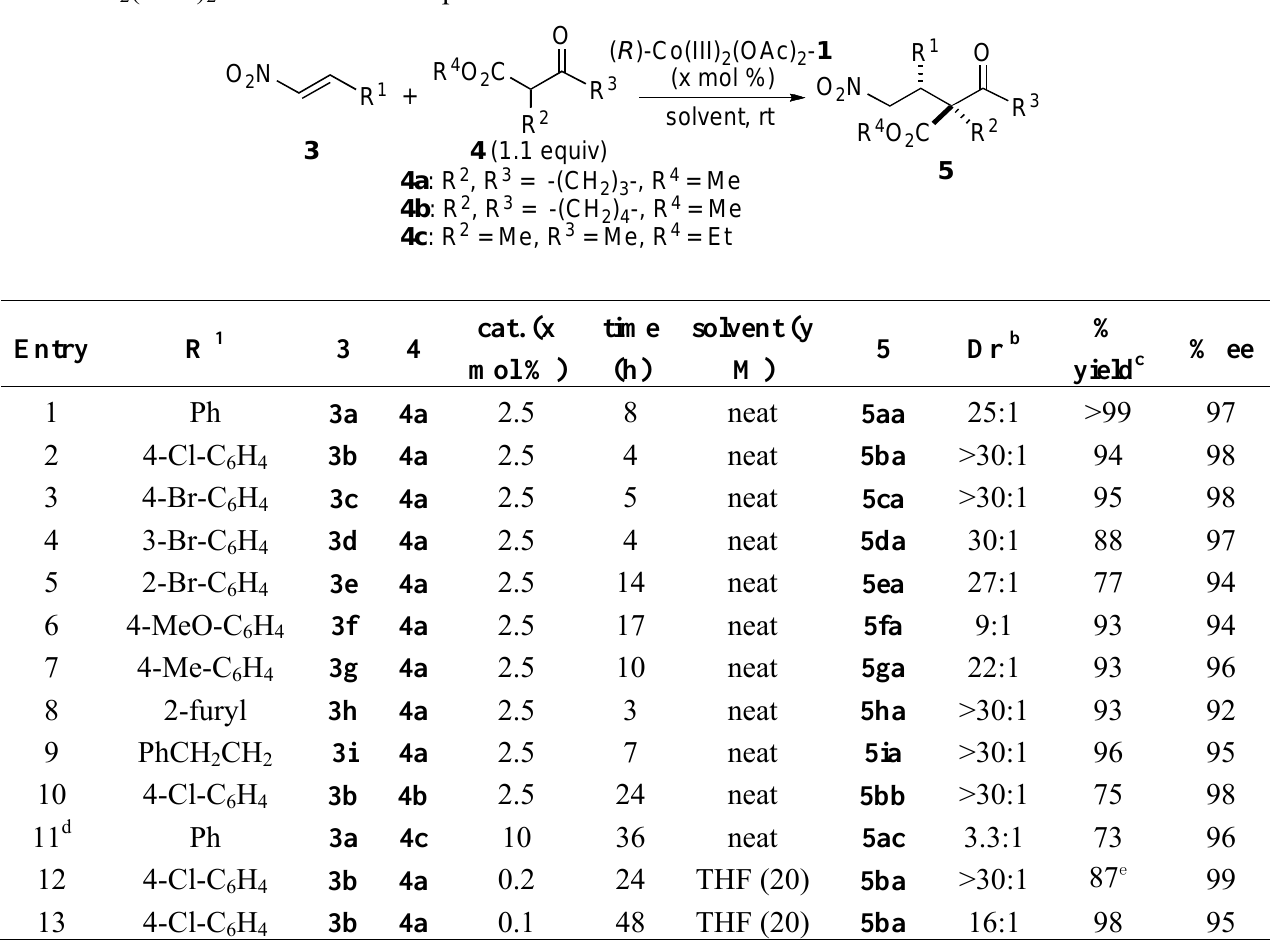
Table 2. Catalytic asymmetric 1,4-addition of β -keto esters to nitroalkenes using (OAc) -Schiff base 1 complex. Co 2 2